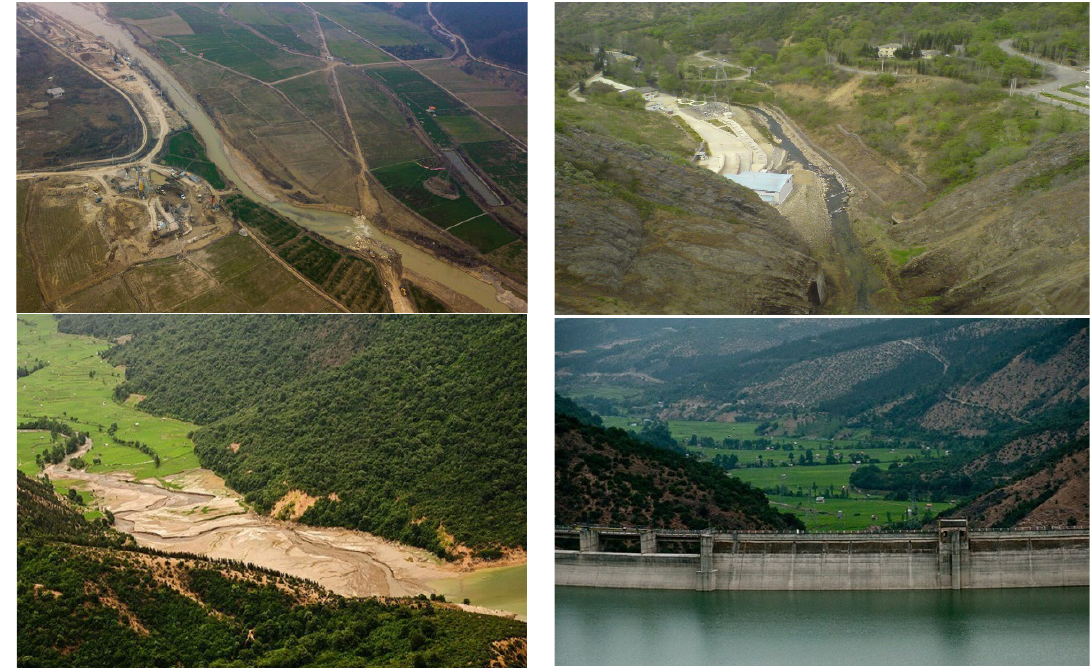
Figure 2. Tajan River and its tributaries. (Irrigation source of rice farms in Sari